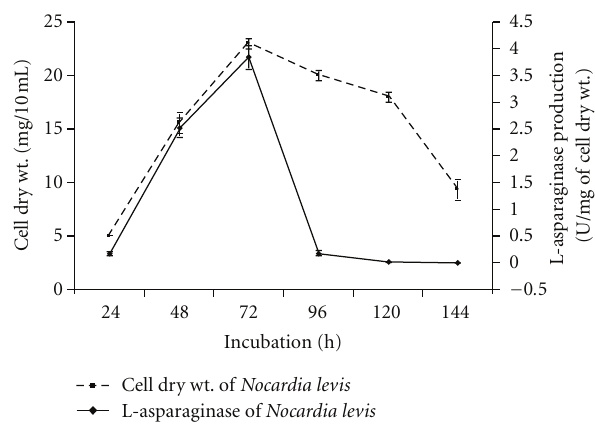
Figure 1: Production profile of L-asparaginase by Nocardia levis MK-VL 113 grown in modified ISP-5 broth. (Values are the means of three replicates ± SD.)